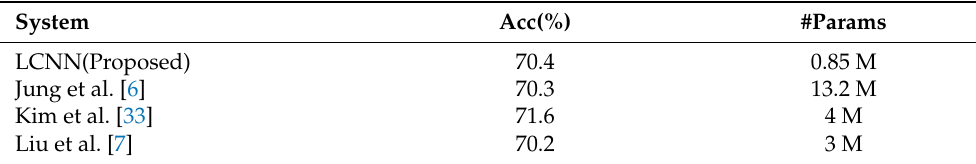
Table 5. Comparison with recent studies using DCASE2020 1A development